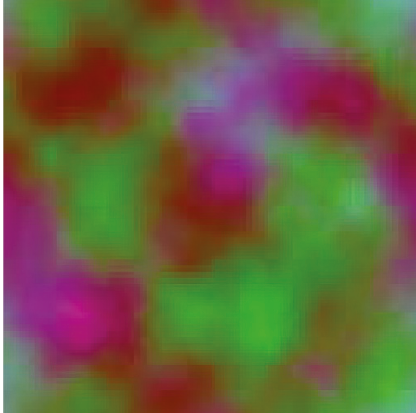
Figure 1: Reference images for the “cloud”